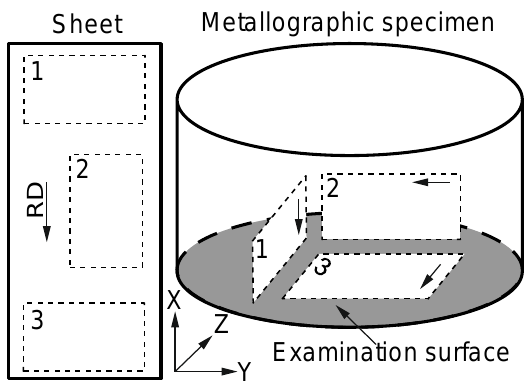
Figure 1. Sample position in the mount for the microstructure analysis. Arrows indicate rolling direction.